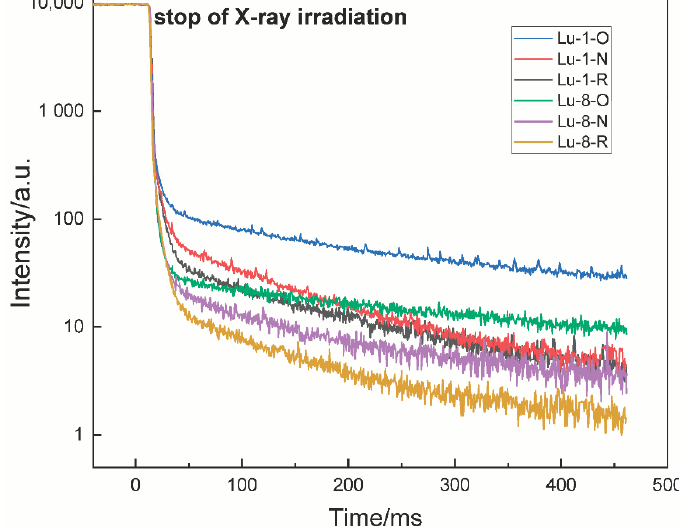
Figure 7. Afterglow curves of Lu 2 O 3 :1%Eu and Lu 2 O 3 :8%Eu single Figure 7. A fterglow curves of Lu 2 O 3 :1%Eu and Lu 2 O 3 :8%Eu single crystals. TSL curves of Lu 2 O 3 :Eu single crystals are reported in Figure 8. The general ‐ order kinetics model was adopted to fit the TSL curves (intensity I as a function of temperature T) by using the following simplified equation, Equation (4) [37]: 𝐼(cid:4666)𝑇(cid:4667) (cid:3404) 𝑠𝑛 (cid:2868) 𝑒𝑥𝑝(cid:4666) (cid:3398) 𝐸 (cid:3047) 𝑘 (cid:3003) 𝑇(cid:4667) (cid:3400) (cid:3420) (cid:4666)(cid:3039)(cid:2879)(cid:2869)(cid:4667)(cid:3046) (cid:3081)